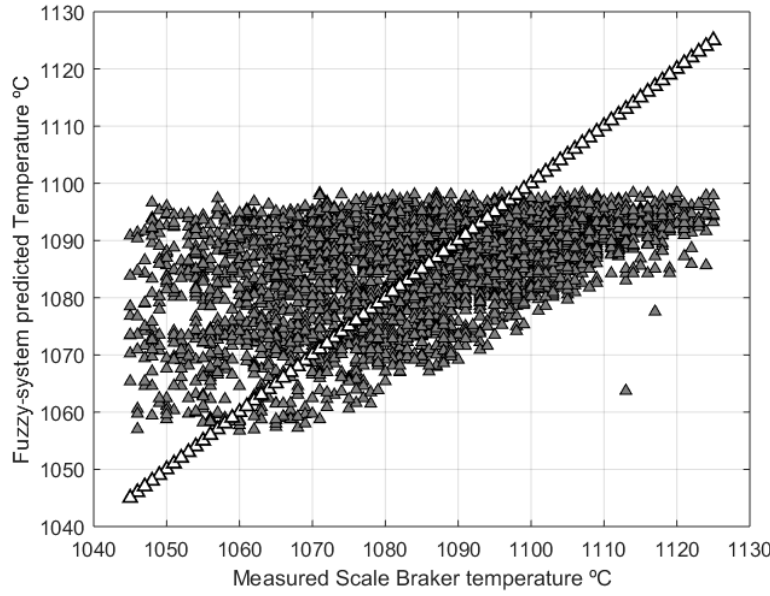
Figure 10. Scatter diagram of the 25-rule HL type-2 Sugeno purely fuzzy system predicted scale breaker entry temperature.